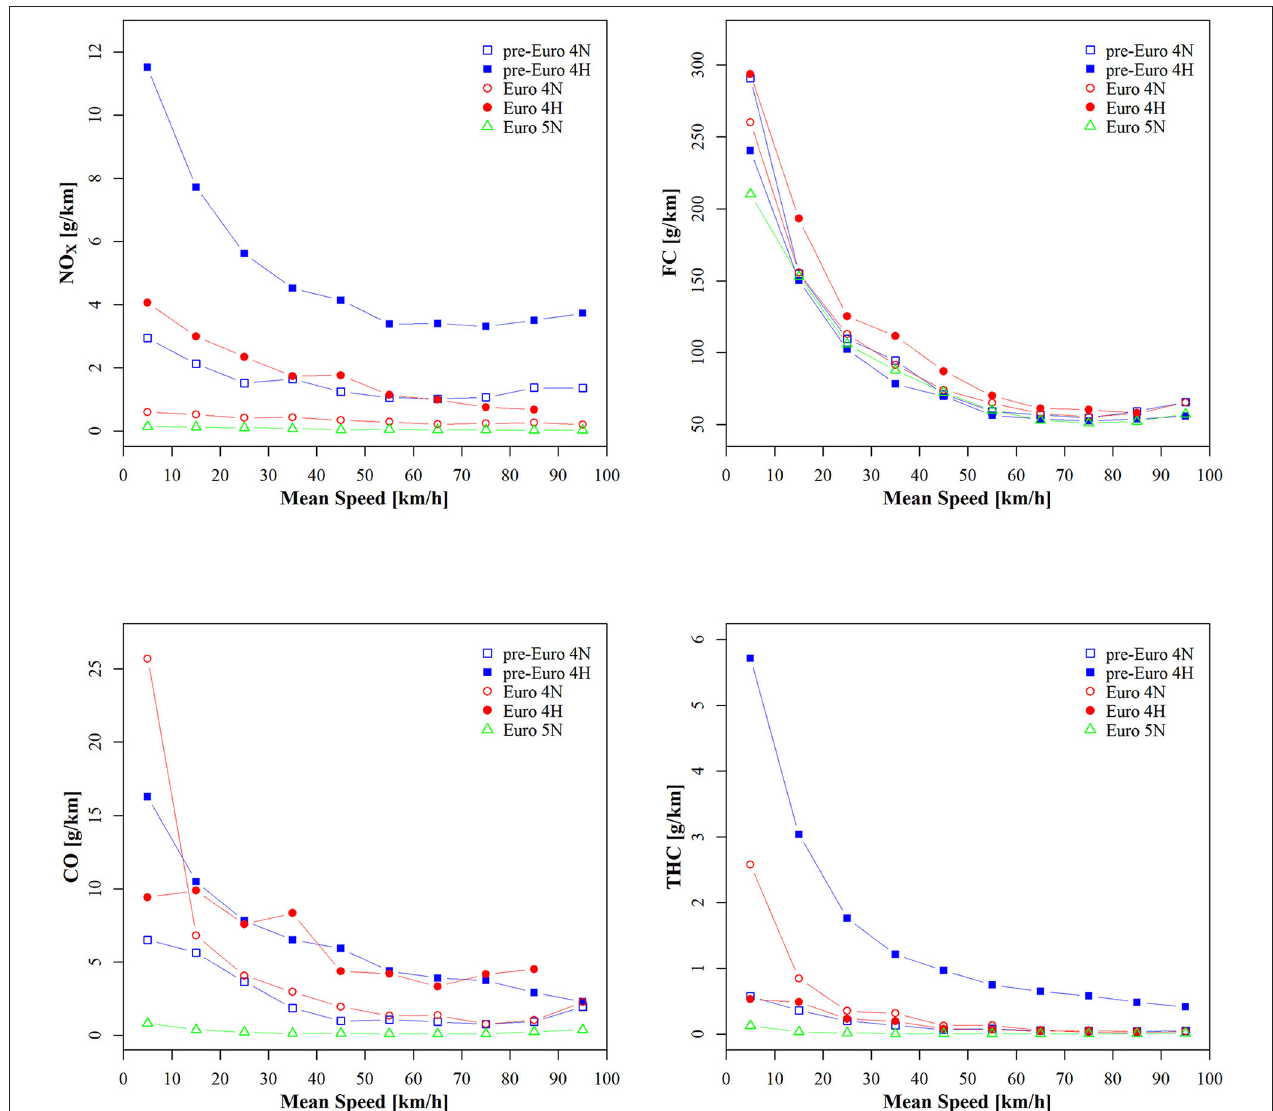
FIGURE 8 | Emissions levels over speed for flat roads for NO x (upper left), FC (upper right), CO (lower left), and THC (lower right) for the various investigated technologies (distance-integration: 500m).